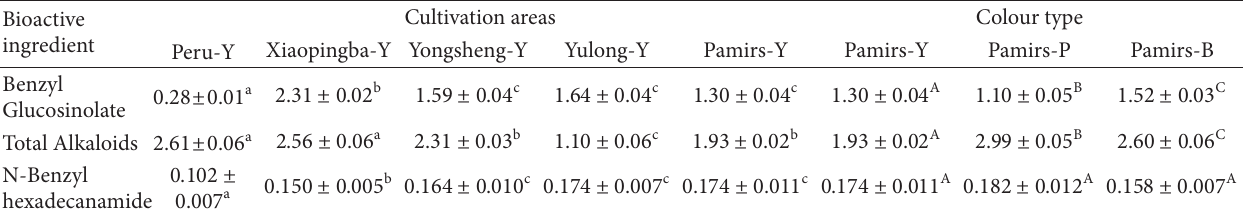
Table 5: Bioactive ingredients contents (mg/g DM) in selected maca samples of different cultivation areas and colour types.